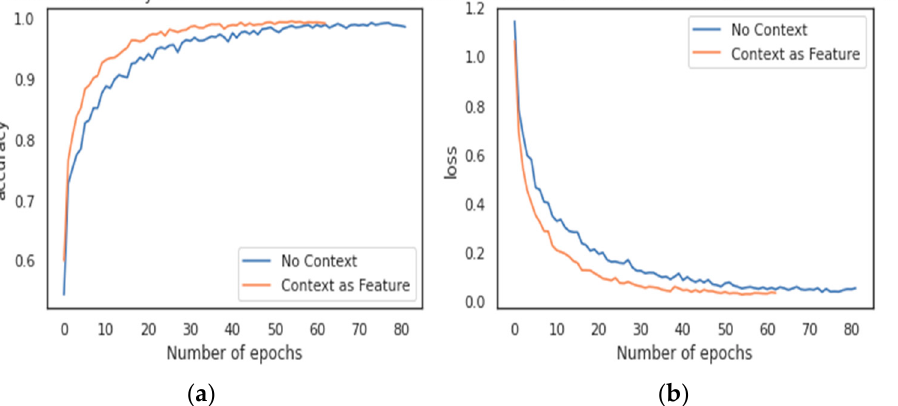
Figure 10. Line plot comparing ( a ) validation accuracy and ( b ) validation loss between the two models during training.